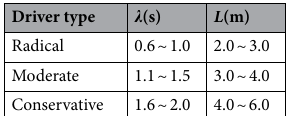
Table 1. Classification and values of driver characteristics